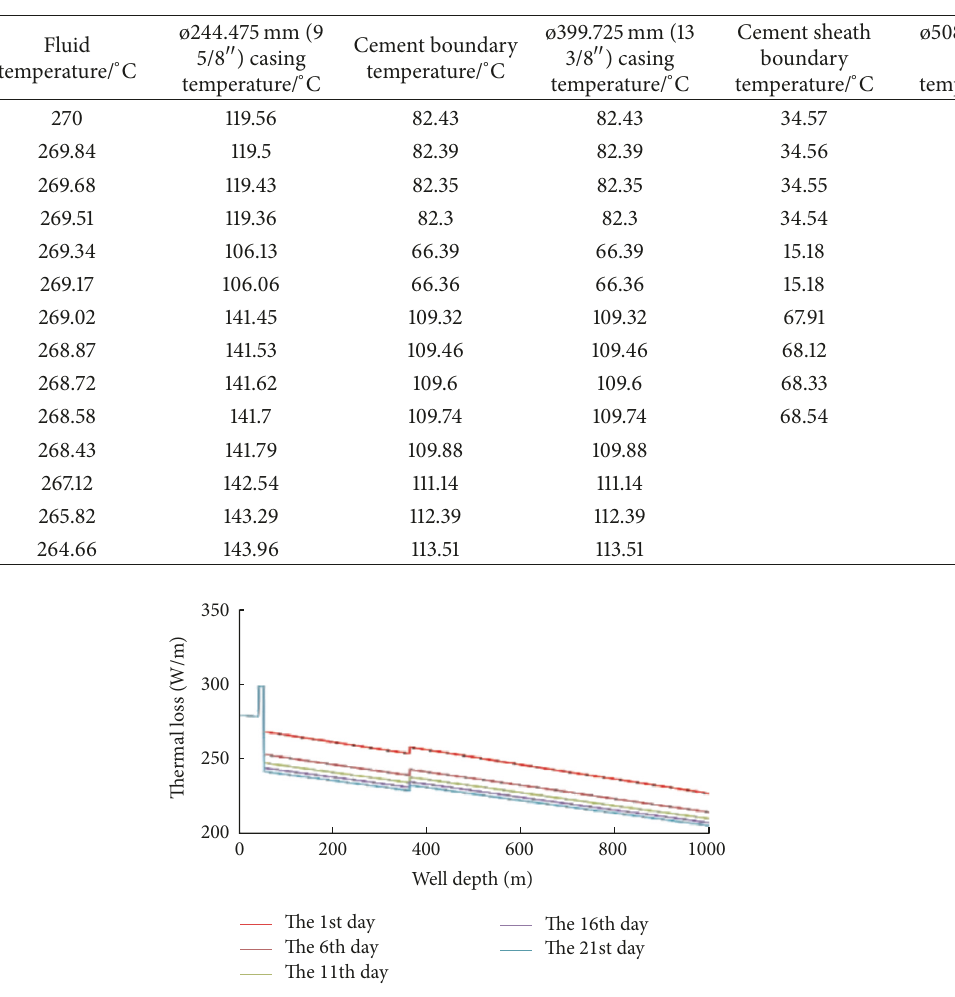
Table 4: Radial temperature distribution to the completion string.